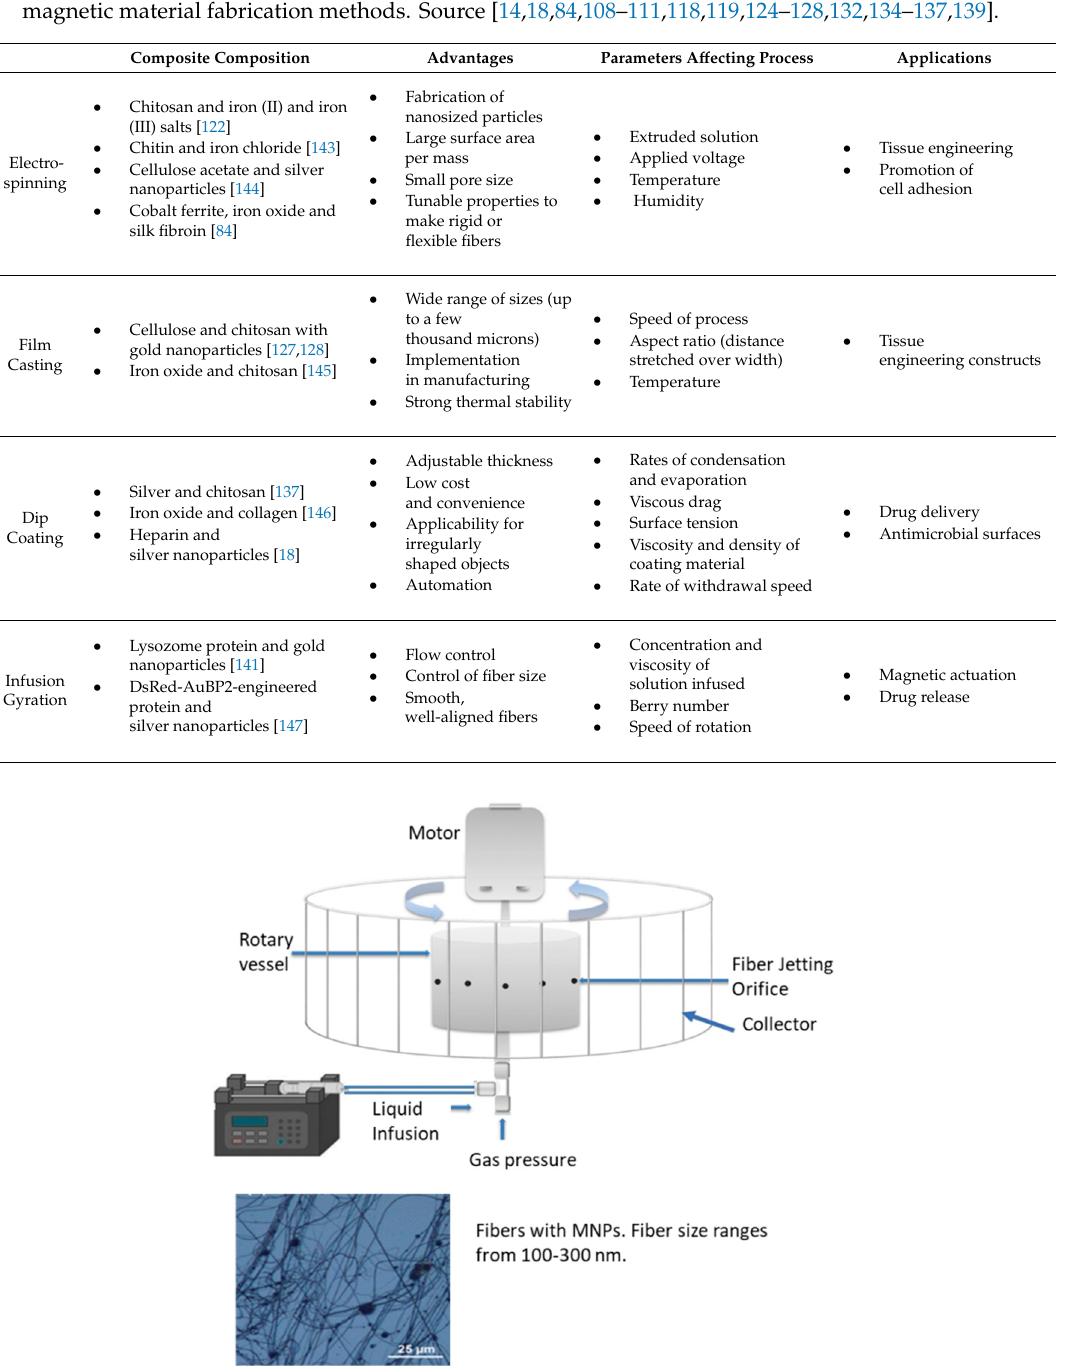
Figure 6. Infusion gyration method of fabrication and examples of fibers created from this method. For example, these fibers are fabricated with the addition of Fe particles at a speed of 36,000 rpm [14,142] (Scale bar is 25 μ m). (Reproduced with permission from Refs [14,142] , ref. [142] : Copyright John Wiley and Sons, 2017; ref. [14] : American Chemical Society, 2018, further permissions related to the material excerpted should be directed to the ACS). Table 2. Advantages, parameters, and applications of the common protein or polysaccharide based magnetic material fabrication methods. Source [14,18,84,108–111,118,119,124–128,132,134–137,139].